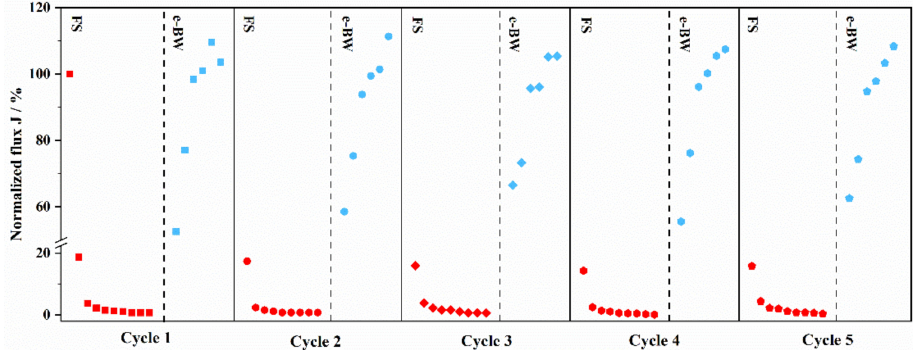
Figure 7. Normalized flux of PbO 2 -REM of the regeneration experiment in the repeated e-BW test. Table 1. Normalized flux of PbO 2 -REM for repeated regeneration in e-BW mode. Normalized Flux (%) Cycle Fouling Regeneration 1st